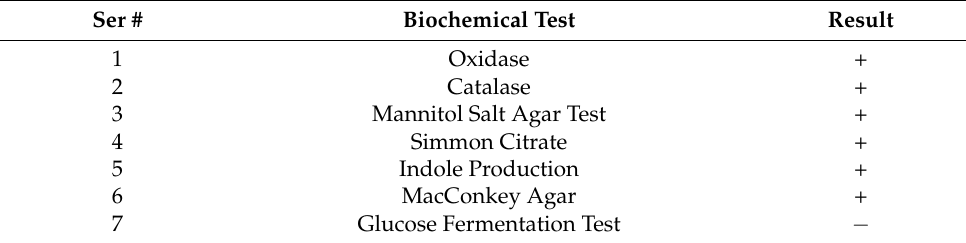
Table 2. Biochemical characterization of RSHG1 bacterial